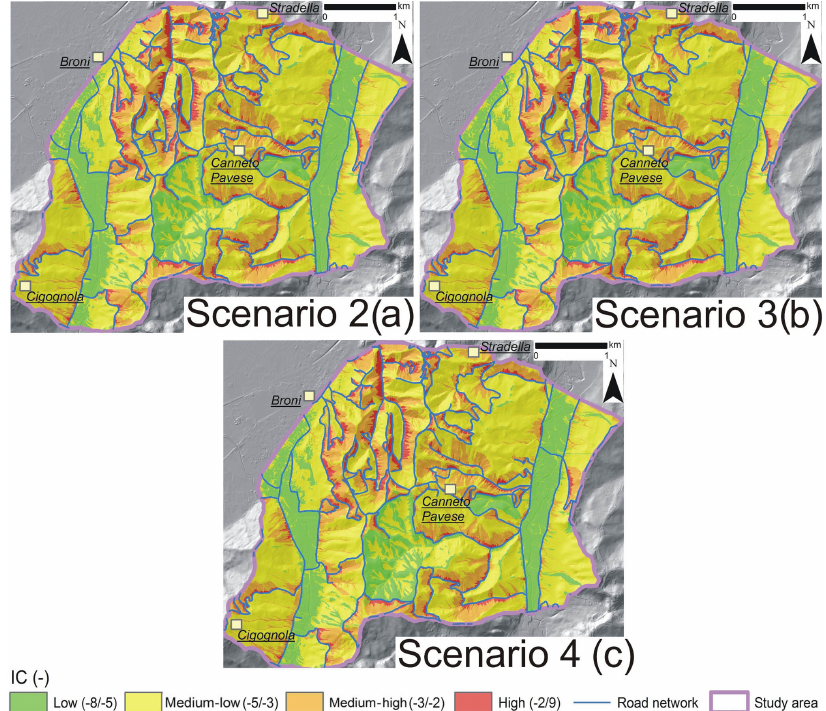
Figure 12. IC lin maps of the different land use scenarios considered: (a) Scenario 2: land use distribution equal to that of 1980 (highest extension of vineyards); (b) Scenario 3: transformation of actual uncultivated areas in woodlands; (c) Scenario 4: increase in abandoned areas similar to that which occurred in 1980–2015